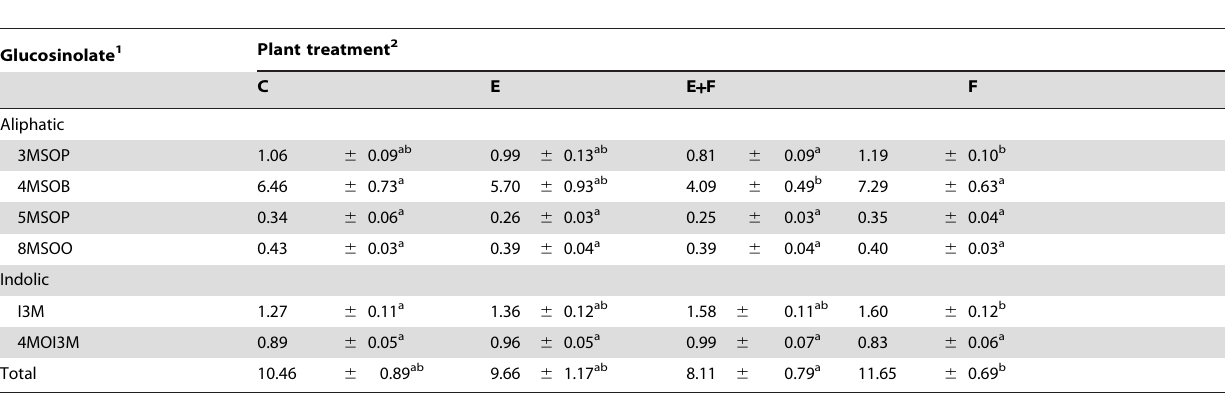
Table 3. Mean ( 6 SE) glucosinolate content ( m mol/g dry weight) of Arabidopsis thaliana Col-0 plants subjected to different Pieris brassicae feeding and egg-laying treatments.